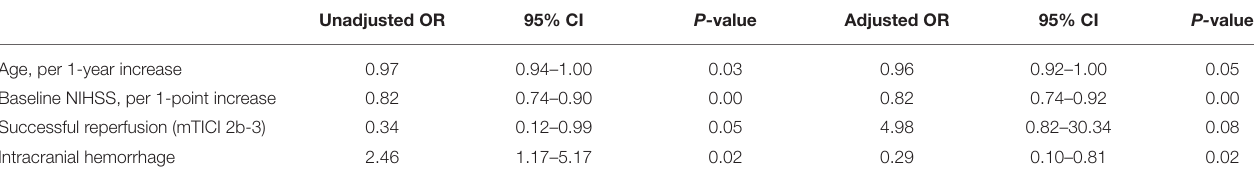
TABLE 3 | Logistic regression analysis of factors associated with a favorable outcome.